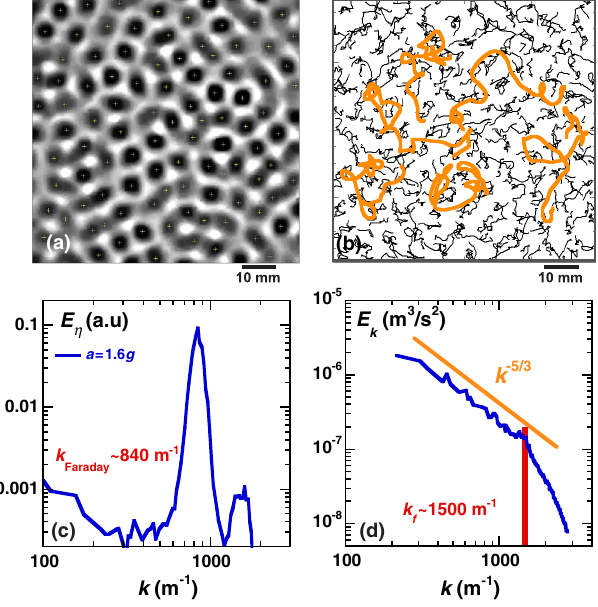
FIG. 3. FW are excited at f 0 ¼ 60 Hz and a ¼ 1 . 6 g ( ϵ ¼ 1 . 67 ) at the water surface (water þ 10% milk þ surfactant) in a 178 mm diameter circular container. (a) Diffusing light image of the fluid surface elevation: peaks and troughs appear as dark and white blobs, respectively. Particles have been removed from the raw image by using a rolling ball algorithm. Local wave maxima (dark peaks) are detected and subsequently followed by PTV techniques. (b) Comparison between trajectories of oscillons FIG. 2. (a) Detection of traps [ δ r ð t Þ < L , blue segments] and L (black lines) having a phase maximum in (a) and an example of flights [ δ r ð t Þ > L , red segments] along particle trajectories L six particle trajectories (orange lines). (c) Wave number spectrum (underlying orange lines). Traps and flights last at least 5 T L of the surface elevation. (d) Wave number spectrum of the kinetic and 3 T , respectively. The forcing frequency is f 0 ¼ 60 Hz, the L energy of the horizontal flow. The horizontal velocity field was ≈ 0 . 10 s. (b) Autocor- Faraday wavelength is λ ≈ 8 mm, and T L measured using PIV techniques (see details in the Appendix). relation function θ ð t Þ of the Lagrangian elevation estimated The red rectangle indicates a spectrally localized forcing mecha- during traps and flights events for a ¼ 1 . 6 g and f 0 ¼ 60 Hz. ≈ 4 mm. nism with a characteristic length scale l Exponentially decaying envelopes are plotted (green and orange f lines). The dashed lines mark successive Faraday shows a wave number spectrum of the horizontal kinetic energy of the fluid in Faraday waves. This spectrum was computed from Eulerian horizontal velocity fluctuations measured using a particle image velocimetry (PIV) tech- acceleration a ¼ 1 . 6 g ( ϵ ¼ 1 . 67 ). Two scaling laws can